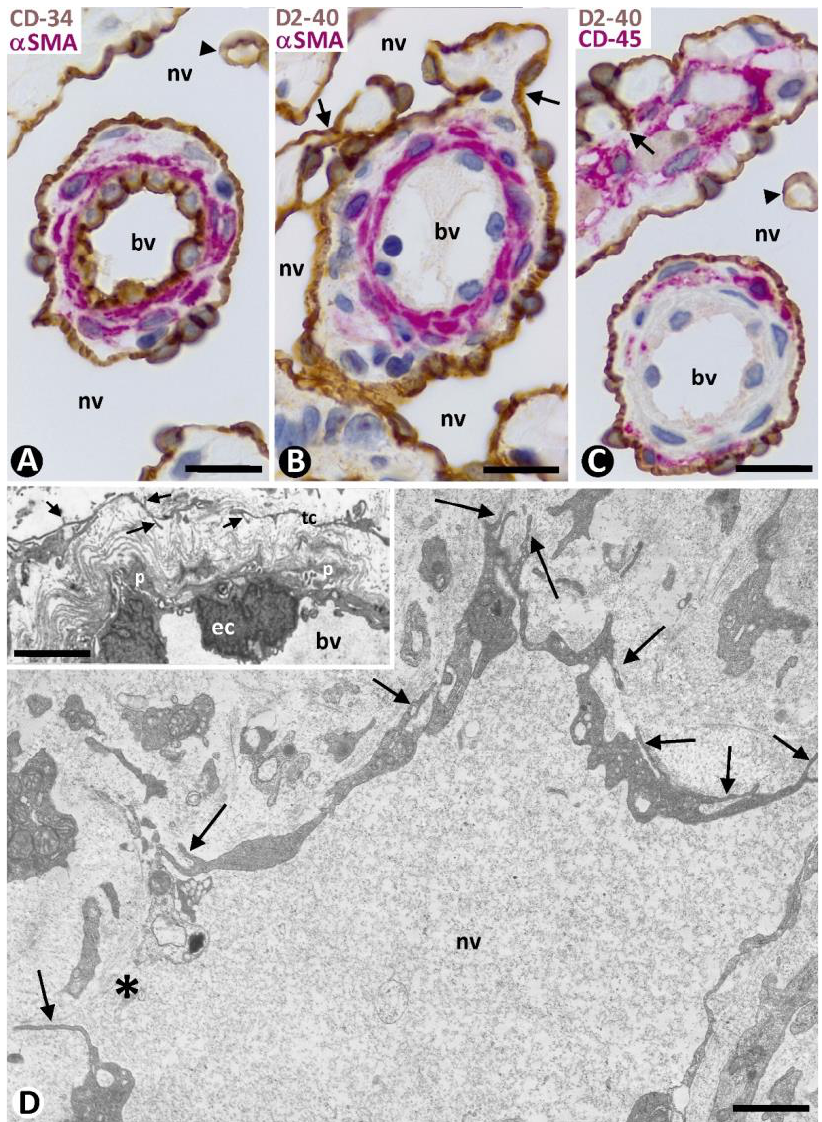
Figure 6. Characteristics of the type 1 neovessel (nv) around pre-existing blood vessels (bv). ( A – C ): Observe that ECs of neovessels express CD34 (( A ), brown) (a marker of blood vessels ECs) and D2-40 (( B , C ), brown) (a marker of lymphatic ECs), while ECs of pre-existing blood vessels only express CD34 (( A ), brown). In ( A , B ) , the pericytes and vascular smooth muscle cells express αSMA (red). In ( C ), CD45+ inflammatory cells (red) are seen in the interstitium and around a pre-existing blood vessel. ( D ): Ultrastructural characteristics of a type 1 neovessel. Alternating thick and thin regions, discontinuity zones (asterisk), and processes extending to the interstitium (arrows) are observed in ECs, resembling telocyte characteristics. In the insert, ultrastructural characteristics of delimiting telocytes (arrows) in a pre-existing blood vessel (bv) with intimal ECs (ec) and pericytes (p). ( A ): Double immunochemistry for CD34 (brown) and α SMA (red). ( B ): Double immunochemistry for D2-40 (brown) and αSMA (red). ( C ): Double immunochemistry for D2-40 (brown) and CD45 (red). ( A – C ): Hematoxylin counterstain. ( D ) and insert: Ultrathin sections. Uranyl acetate and lead citrate. Bar: ( A – C ): 20 µm; ( D ): 2.5 µm.